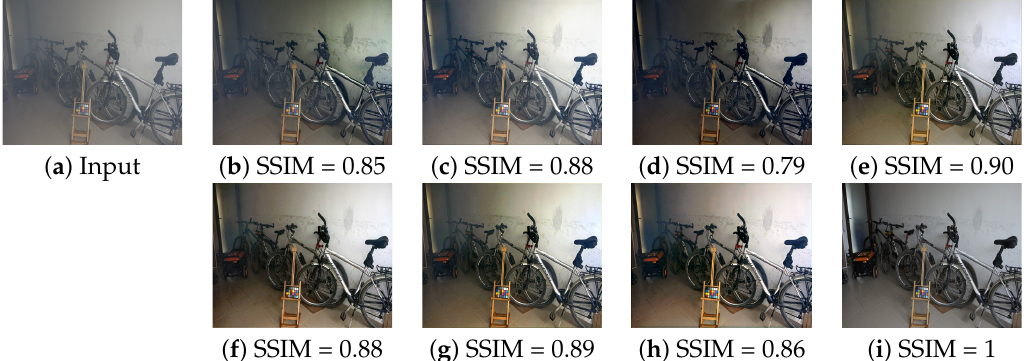
Figure 5. Comparison of dehazed image using I-Haze: ( a ) Haze input, ( b ) NL, ( c ) DCPDN, ( d ) RRO, ( e ) TCN, ( f ) DVNet-NL, ( g ) DVNet-RRO, ( h ) DVNet-NYU, and ( i ) Ground Truth.